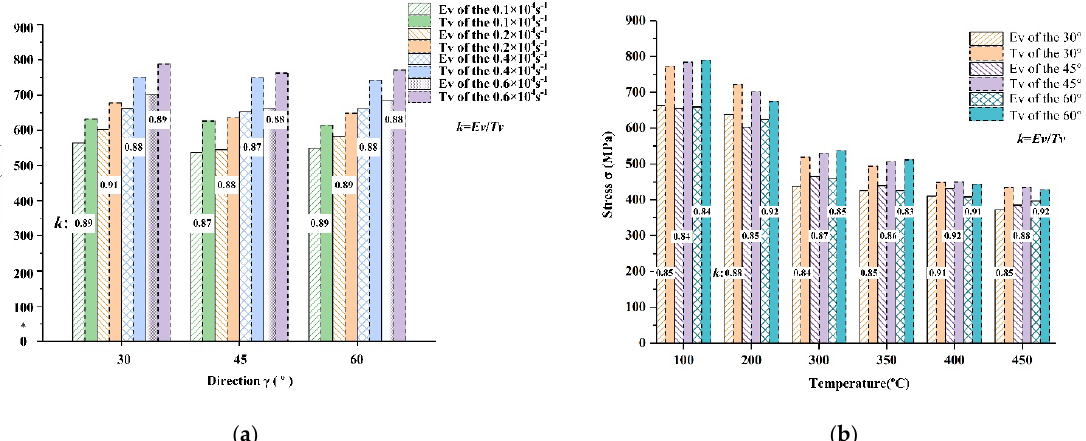
characterized and verified to establish a constitutive relationship containing the spatial angle. In order to further verify the accuracy of the theoretical method, the theoretical value was verified using the results of the dynamic impact compression test. The stress obtained by ′ , in the load coordinate system. The dynamic impact compression is the normal stress stresses in the stable stage depicted in the stress–strain curves at different strain rates in differ- 𝜎𝜎 𝑥𝑥 ent directions were selected and verified. The verification results are presented in Figure 10.